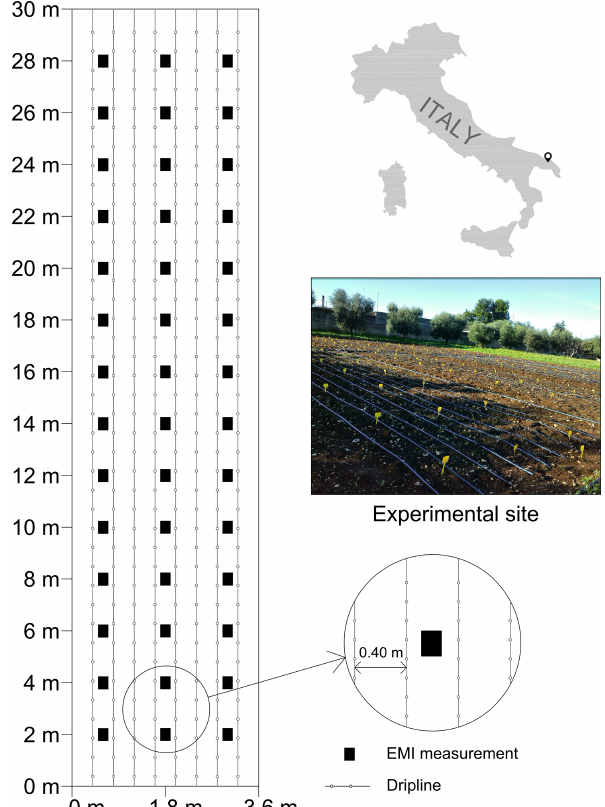
Figure 1. A schematic display of the experimental set-up. Four ex- perimental plots were designed equally and irrigated with the same amount of water at four different salinity